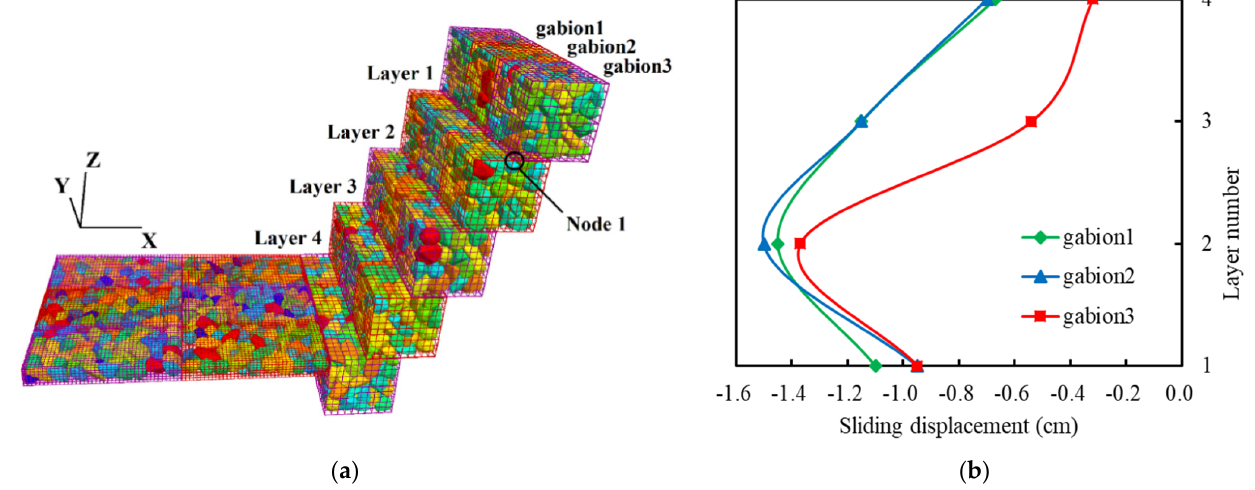
Figure 19. Slip displacement of BFR gabions. ( a ) Schematic diagram. ( b ) Sliding displacement.